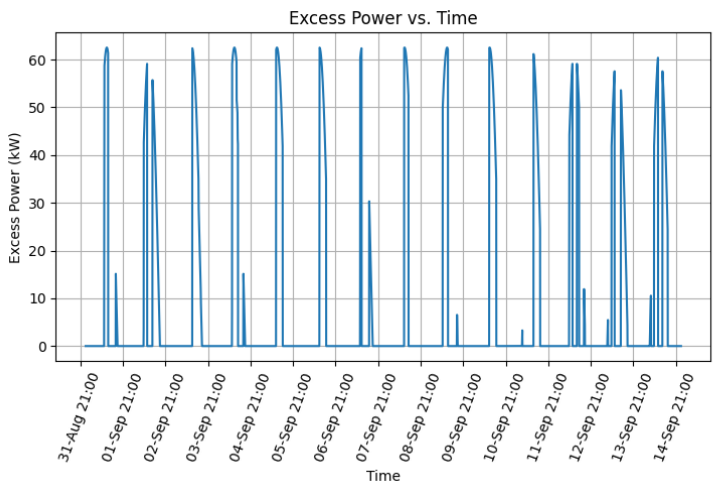
Figure 15. Excess power for a microgrid with 60 kW diesel generation capacity, 81 kW photovoltaic power rating and 360 kW h BESS. · ·